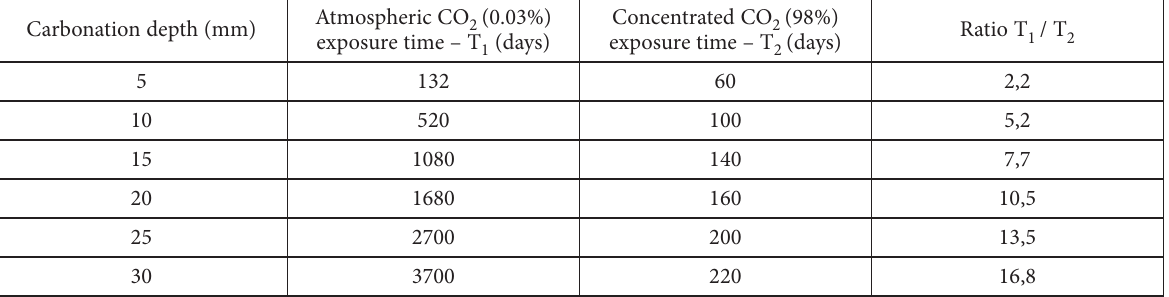
Table 2. Comparison of carbonation times of the identical layers of concrete in the environment of a real atmosphere ) and in the highly concentrated environment of 98% CO (0.03% CO 2